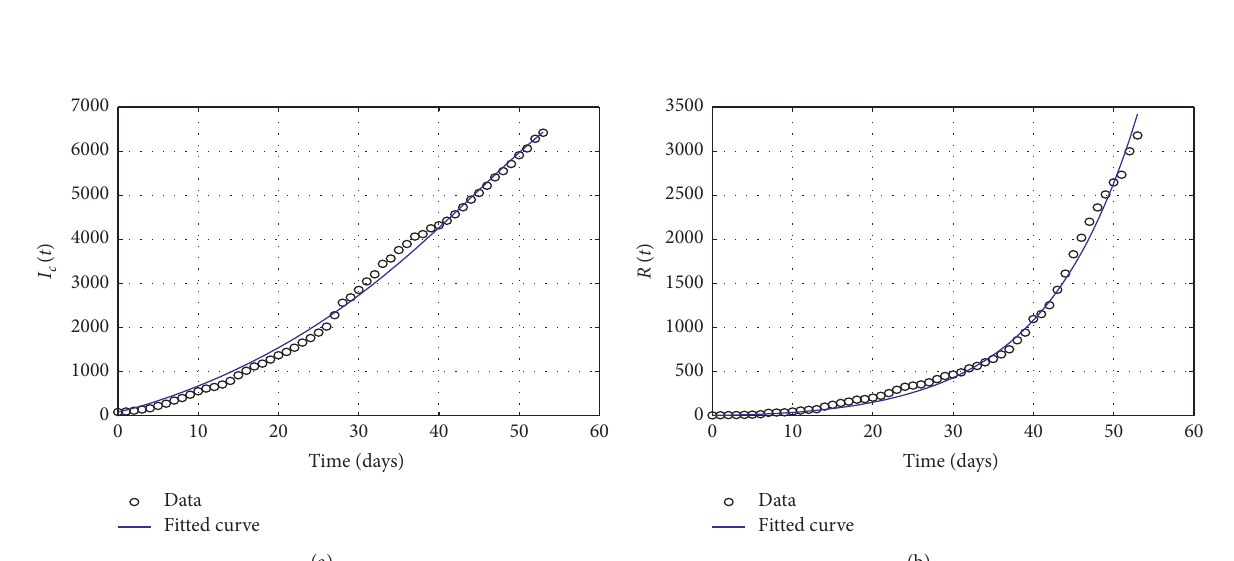
Figure 2: The reported diagnosed and removed individuals and their best fit to model (2). (a) Real data and fitted curve for I and fitted curve for R